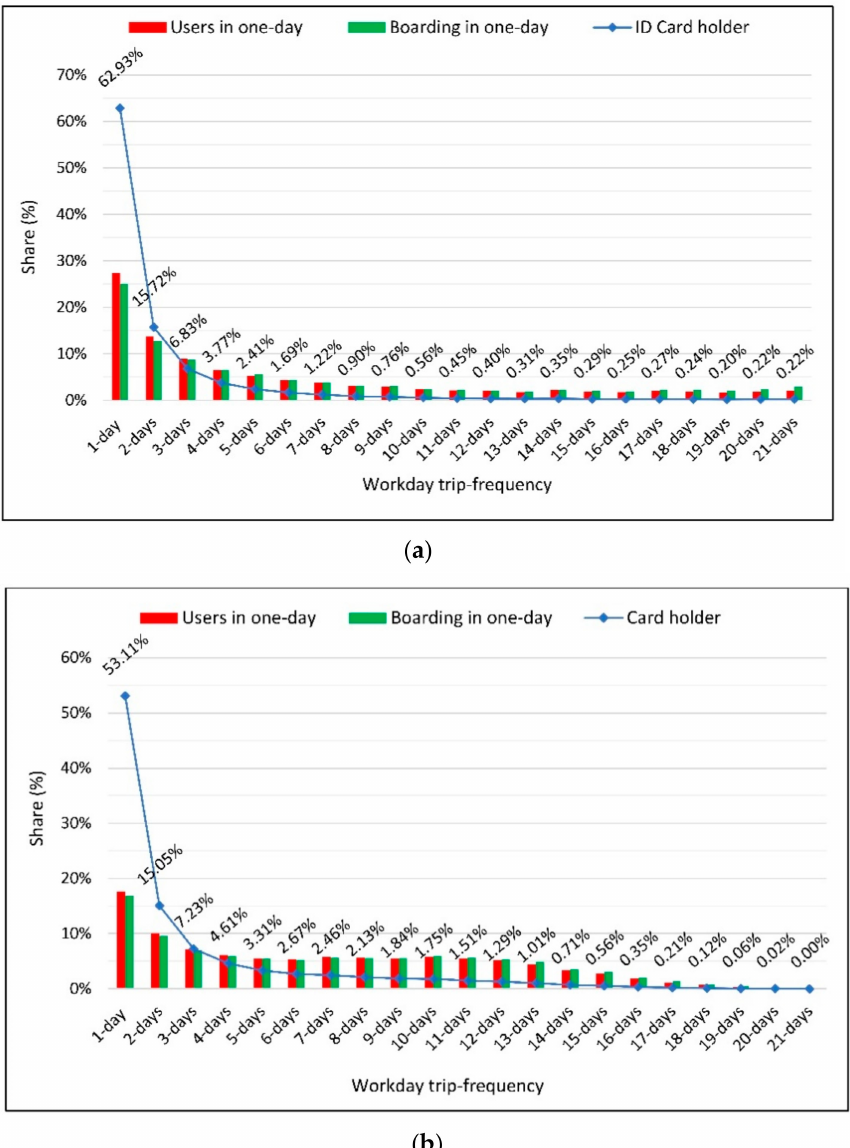
Figure 8. Comparing 1-day data and 1-month data in terms of number of users and boarding for: ( a ) Bus Line No. 118 and ( b ) Bus Line No.